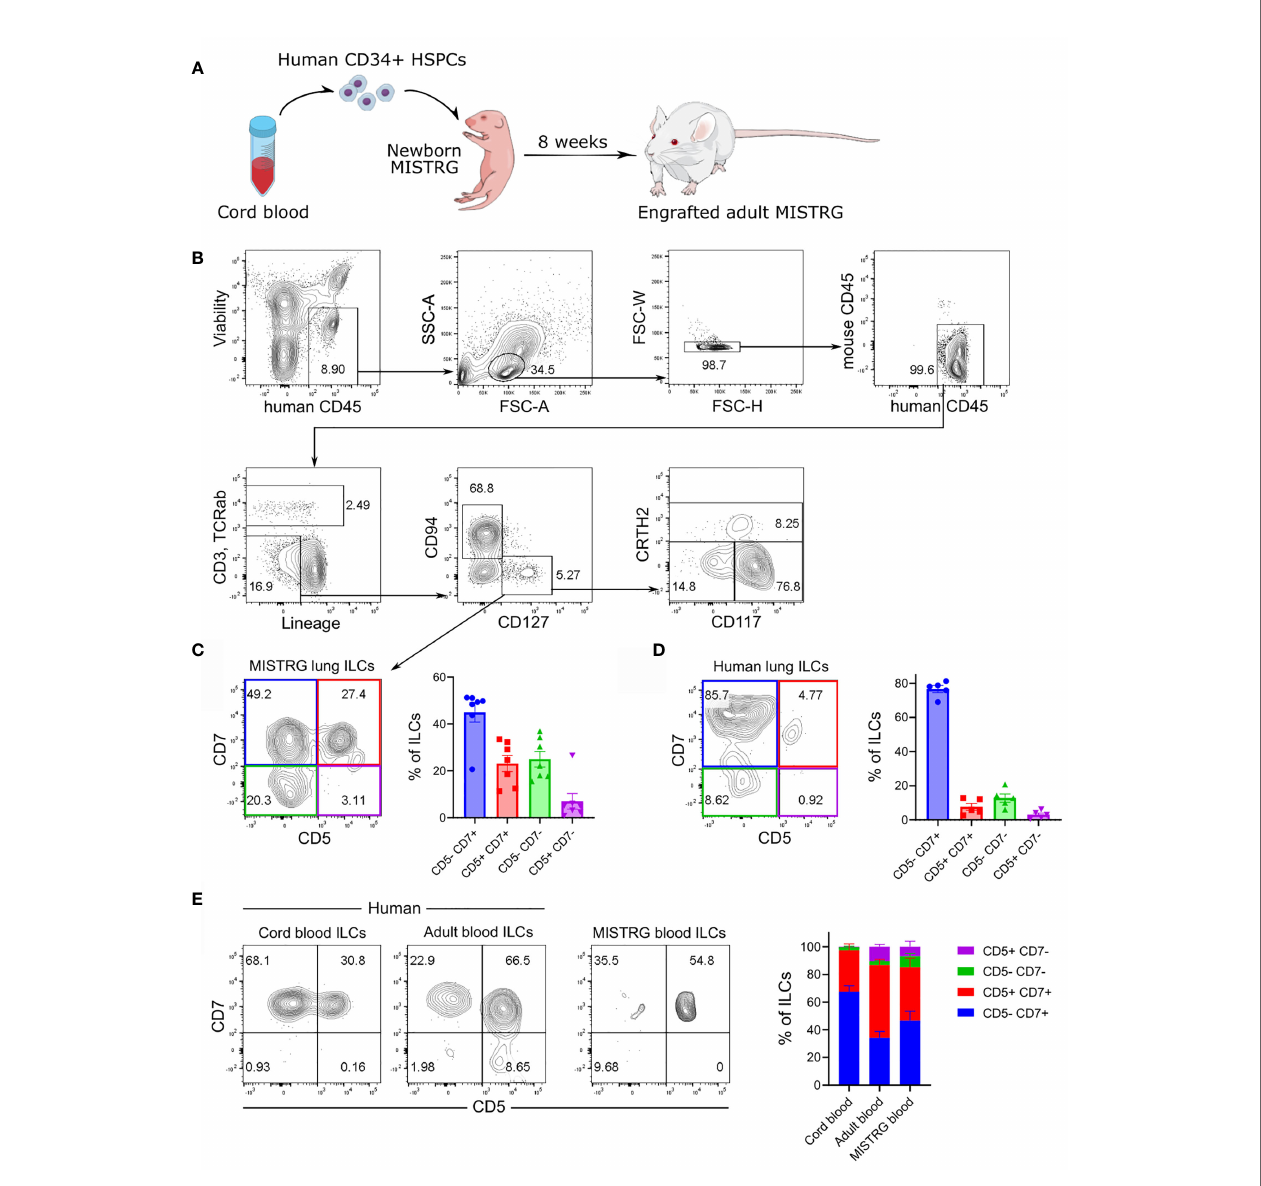
FIGURE 1 | Human CD5 + ILCs are present in the lung and peripheral blood. (A) Engraftment of newborn MISTRG mice with human CD34 + HSPCs from cord blood. (B) Gating strategy for the fl ow cytometric analysis of human ILCs in the lung of HSPC-transplanted MISTRG mice. Total ILCs were gated as viable human CD45 + CD3 - TCR ab - CD94 - CD127 + cells that were negative for lineage (Lin) markers (CD11c, CD14, CD19, CD34, CD123, FceRI) and mouse CD45. (C, D) CD5 and CD7 surface expression on human lung ILCs. Frequencies of CD5/CD7-expressing ILC subsets in the lung of HSPC-engrafted MISTRG mice (n = 7) and in human lung tissue (n = 5) are shown in (C, D) , respectively. (E) Frequencies of CD5/CD7-expressing ILC subsets in human cord blood, human adult blood, and in the blood of HSPC-transplanted MISTRG mice was determined by fl ow cytometry (n = 7-11). Data are represented as mean ± SEM. Data are from at least three independent experiments. (A) was adapted from Mind the